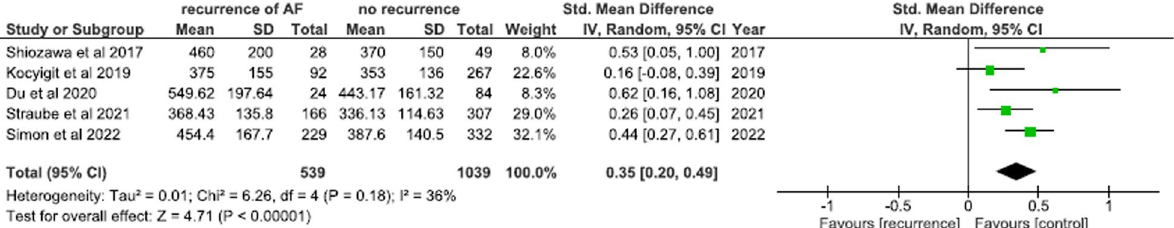
Fig. 5 Mean difference in LAA orifice area between arrhythmia recurrence and arrhythmia free